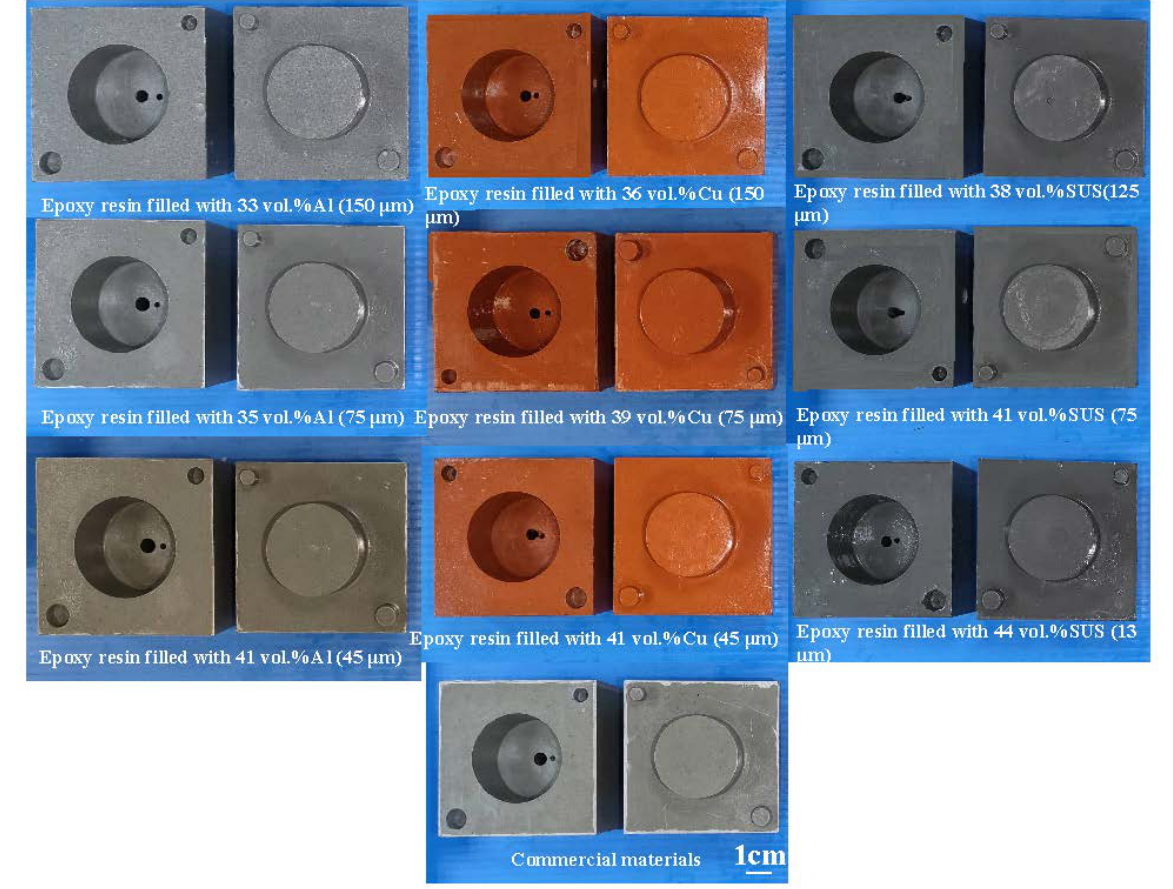
Figure 8. Ten pairs of injection molds for low-pressure wax injection molding.